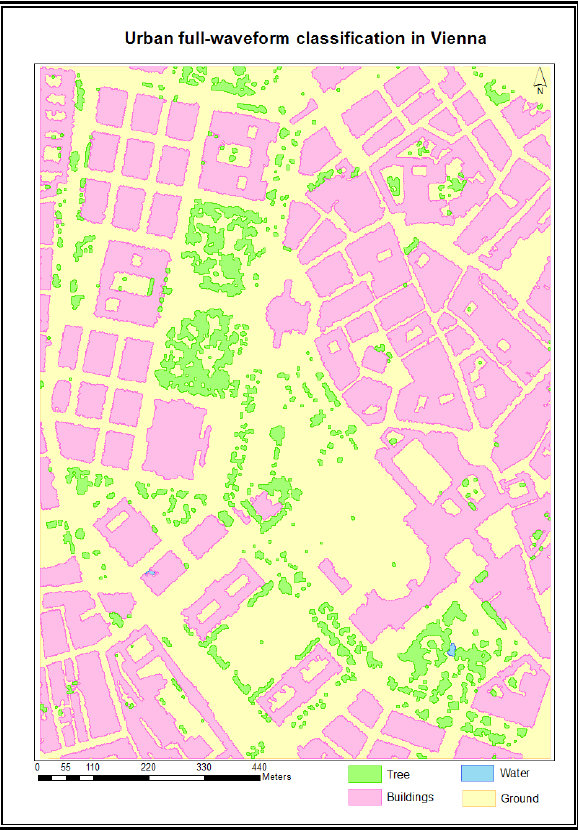
Figure 3. Urban full-waveform classification in